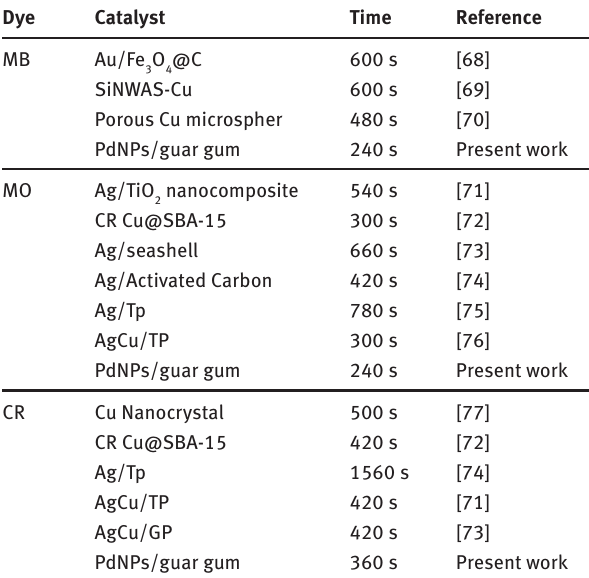
Table 3: Comparison of this work with reported work in the degradation of MB, MO, and